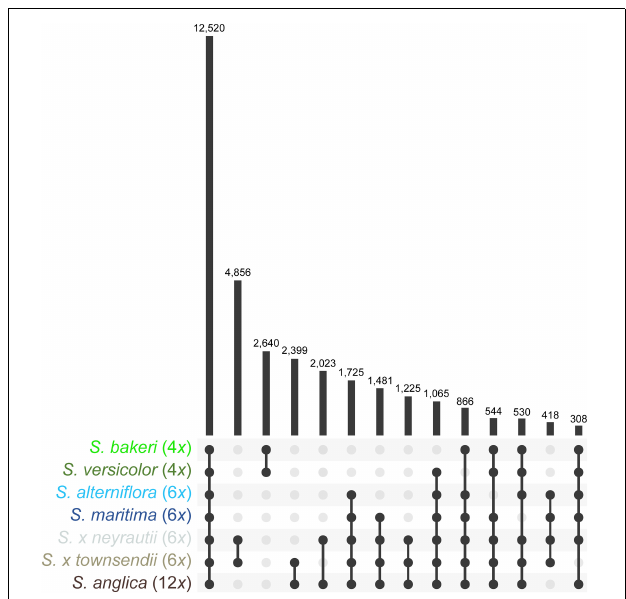
FIGURE 2 | Orthologs found within reference transcriptomes of Spartina species. Values represent the number of clusters retrieved in two or more